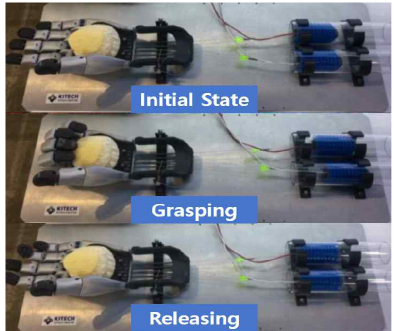
Figure 13. The actuator module is applied for robot hand grasping. The two actuator module grasped and released an object successfully. The total weight of the five fingers was M = 70 g, approximately, but there existed energy loss caused by the silicone ligaments between finger joints; therefore, we applied two actuator modules. Ω = 160 rev/s was